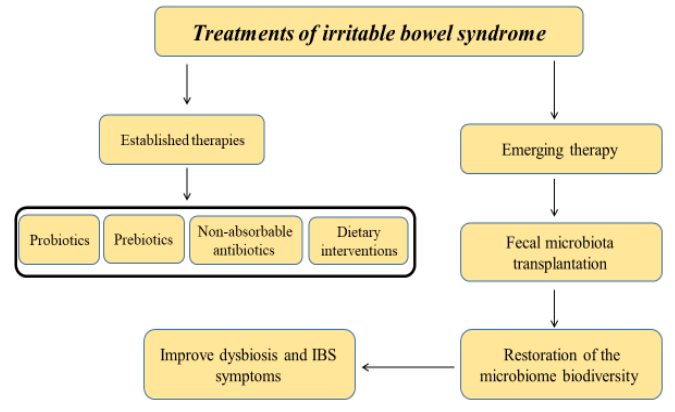
Figure 2. Treatments of irritable bowel syndrome (IBS) by targeting the gut microbiome.